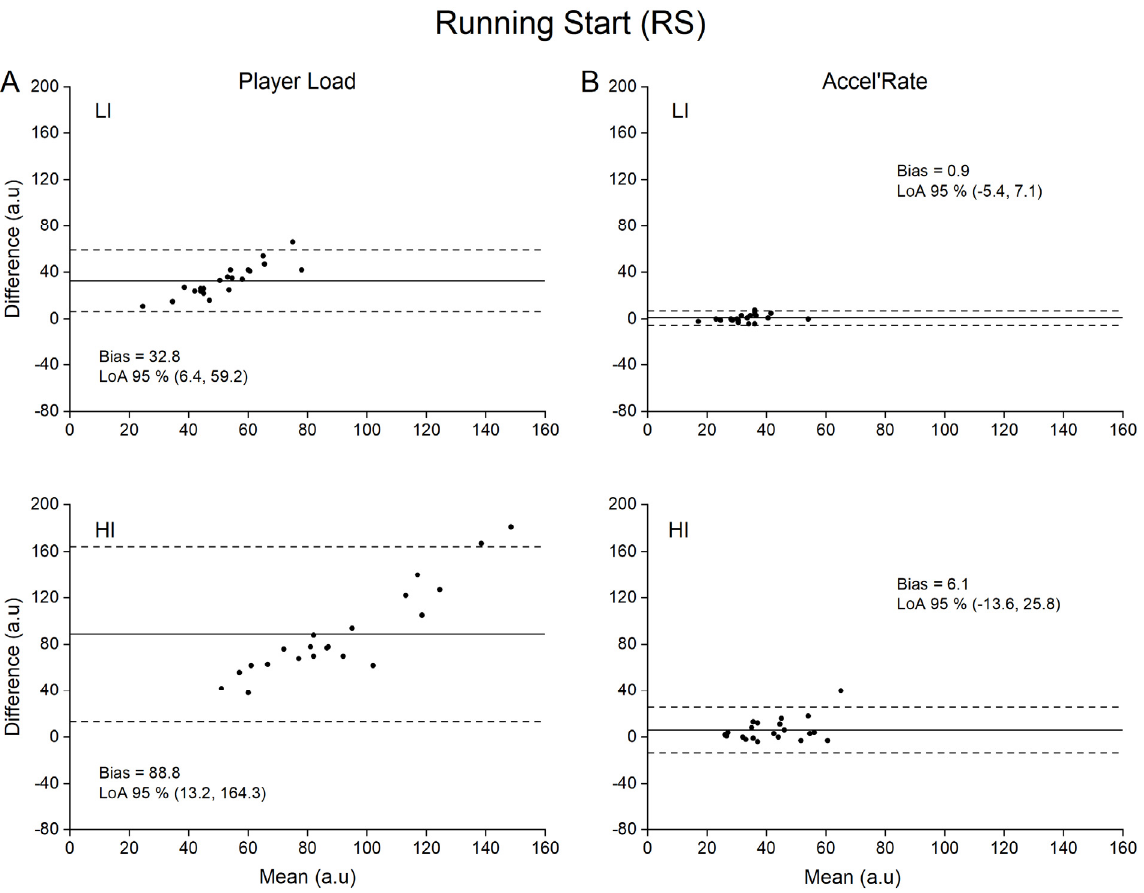
Figure 3. Bland-Altman plots of difference between criterion and practical measurements for running start (RS). For the sake of clarity, only data obtained for the upper back position are depicted. ( A ): Player Load measured by accelerometer (practical) versus by force plates (criterion) at low (LI) and high (HI) intensity; ( B ): Accel’Rate measured by accelerometer (practical) versus by force plates (criterion) at low (LI) and high (HI) intensity. Solid lines depict mean bias and dashed lines depict 95% limits of agreement (LoA).